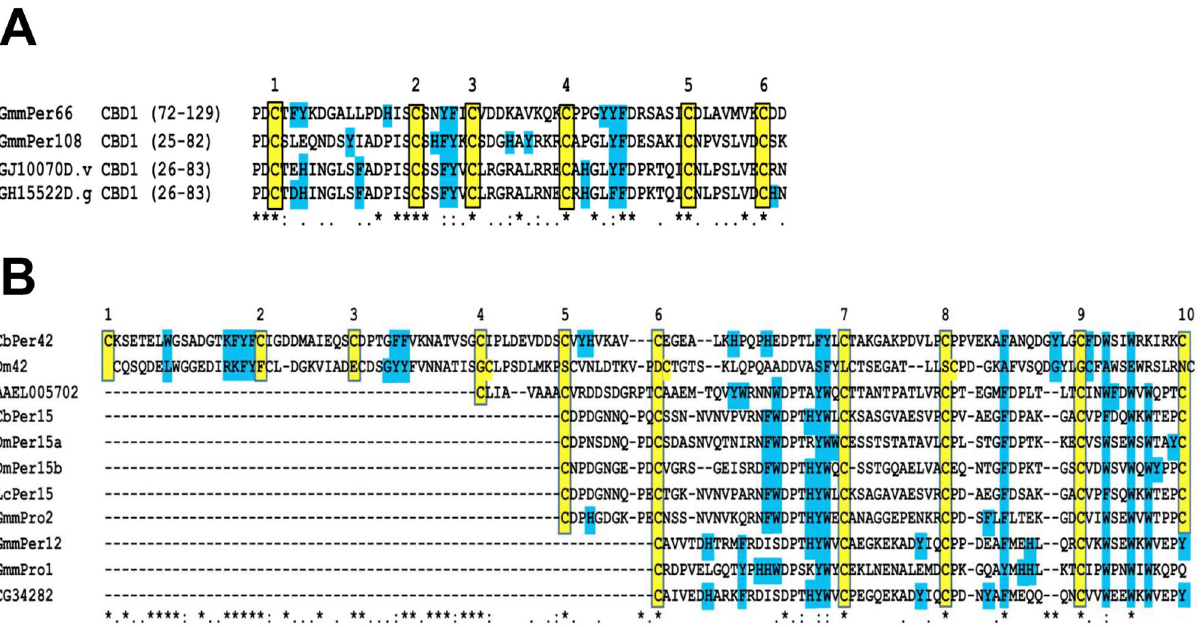
Figure 5. Chitin Binding Domains of tsetse peritrophins as identified by LC-MS/MS aligned against other representative domains from putative Dipteran peritrophins. The positions of the domains within the sequence are shown next to their respective protein IDs for panel A only. The 10 and 6 conserved cysteine residues of a PCD (A) and PAD (B) respectively, which are potentially involved in disulphide bridge formation, are indicated by yellow boxes and asterisks (*). Note the partial PCD of many peritrophins including those in Glossina . The numbers above the cysteine residues depict the order of cysteines in the CBD. The conserved aromatic residues, characteristic of chitin binding domains, are denoted by blue boxes and may be involved in carbohydrate binding. Identity of amino acid residues is depicted according to